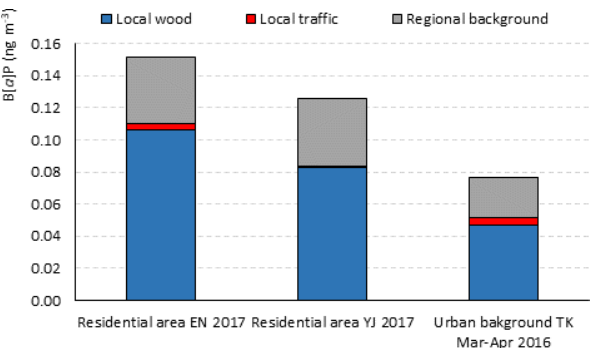
Figure 8. Modelled concentrations of B[ a ]P in Stockholm com- pared with measured values. In urban background (TK), the re- gional background data are from 29 February–2 May and measured data from 28 February–1